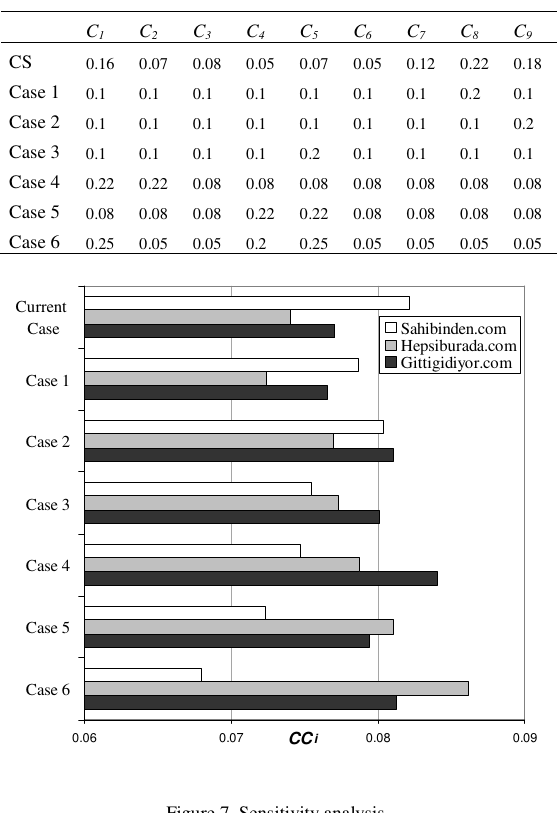
Figure 7. Sensitivity